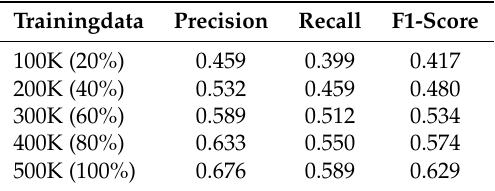
Table 5. The influence of number of training data in Twitter dataset.